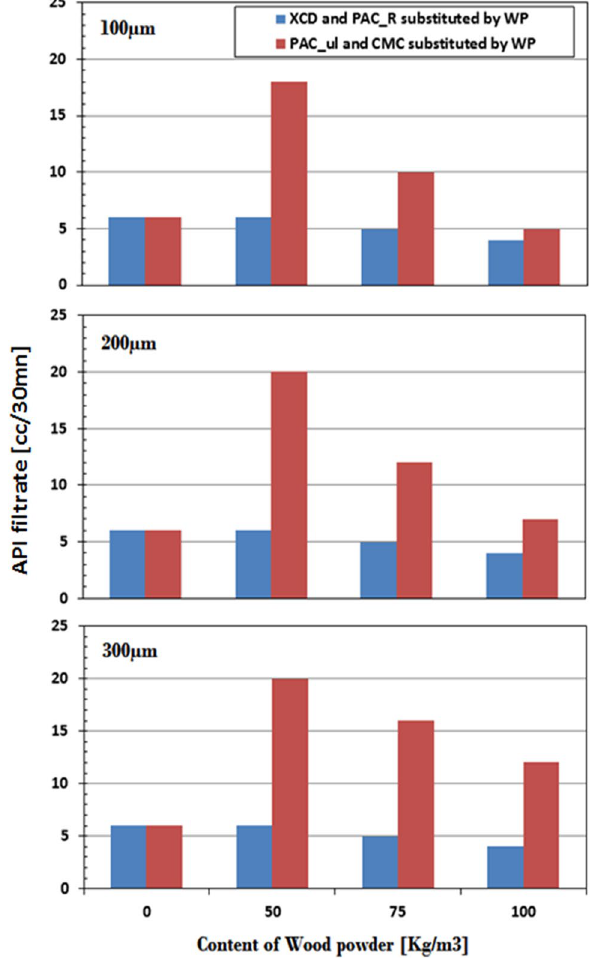
Fig. 10 Mud filtrate of studied muds at different polymer substitution and wood